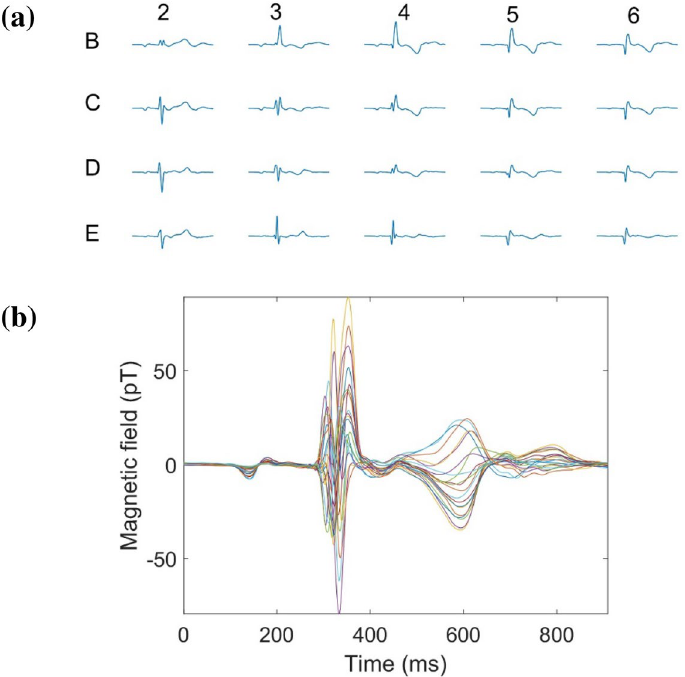
Figure 7. ( a ) The MCG preprocessed by ICA-EMD at the 20 spatial locations for a single epoch (unaveraged). ( b ) Butterfly of